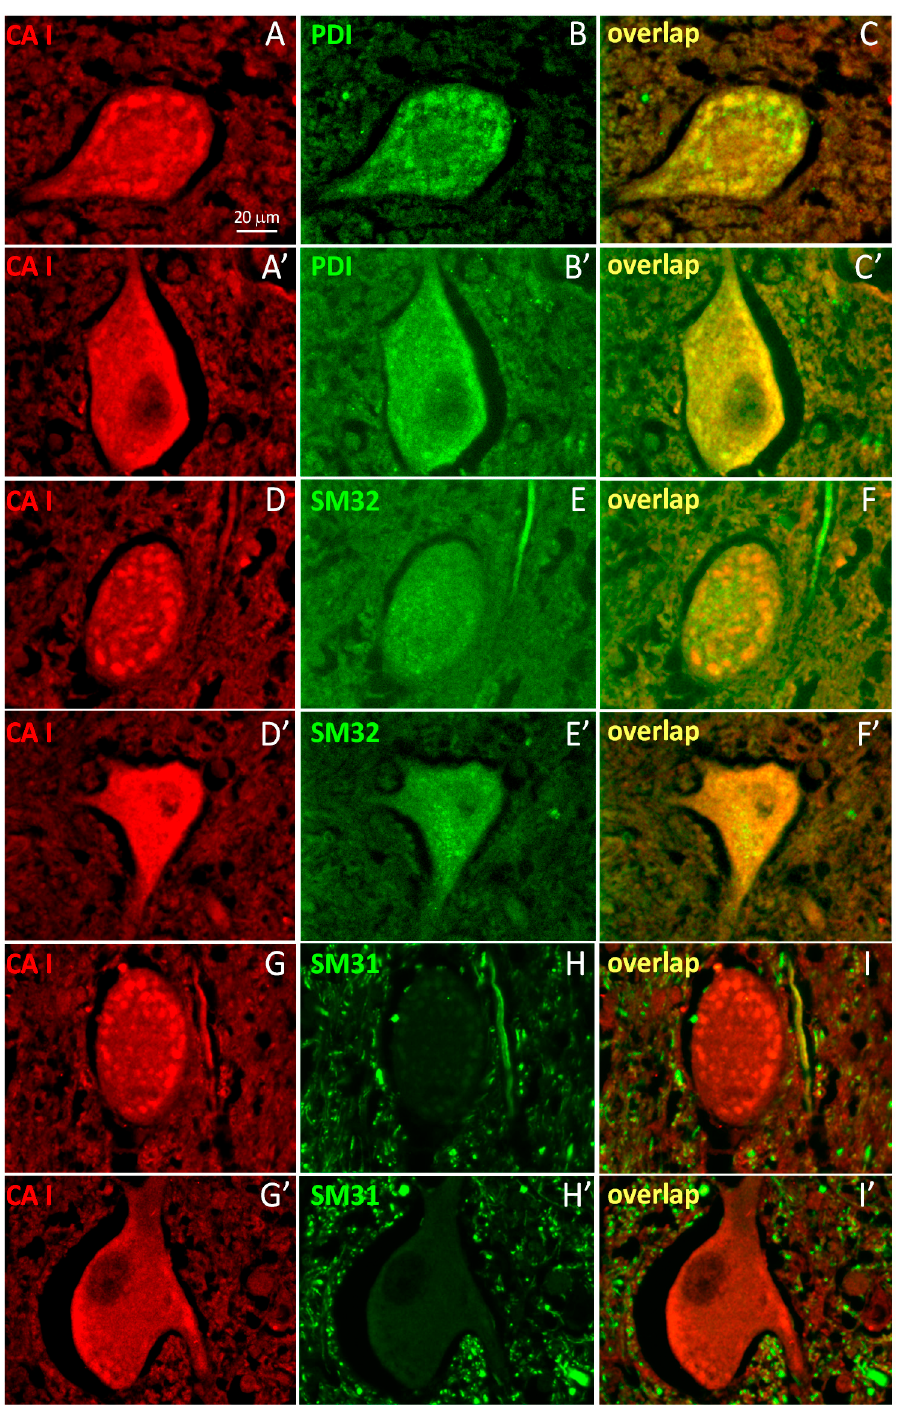
Figure 2. The punctate CA1-immunoreactivity co-localizes with the ER marker in control spinal cord motor neurons. Images are motor neurons double-labeled with fluorescent antibodies against CA1 ( red , G α CA1, 1:100) and PDI ( green ) or neurofilaments (SM31, SM32, green ) and the overlapped signals are shown in the far right panels. Images were from spinal cord sections of three control subjects (Supplementary Materials, Table S1, A–C) Two representative motor neurons of each double-labeling set are presented: CA1 and PDI ( A – C , A’ – C’ ); CA1 & SM31 ( D – F , D’ – F’ ); and CA1 and SM32 ( G – I , G’ – I’ ). The white scale bar indicates 20 μ m.